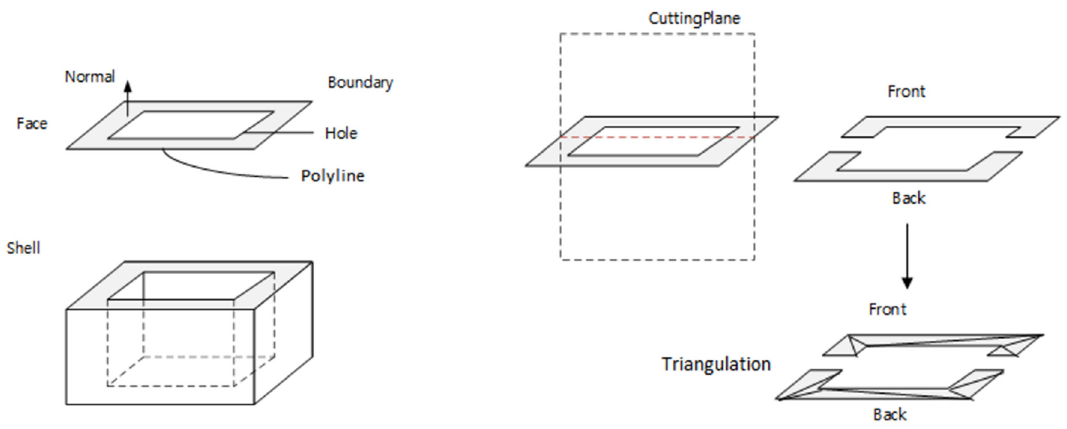
Figure 2. Fundamental data structure used to project a 3D shape onto a 2D drawing.